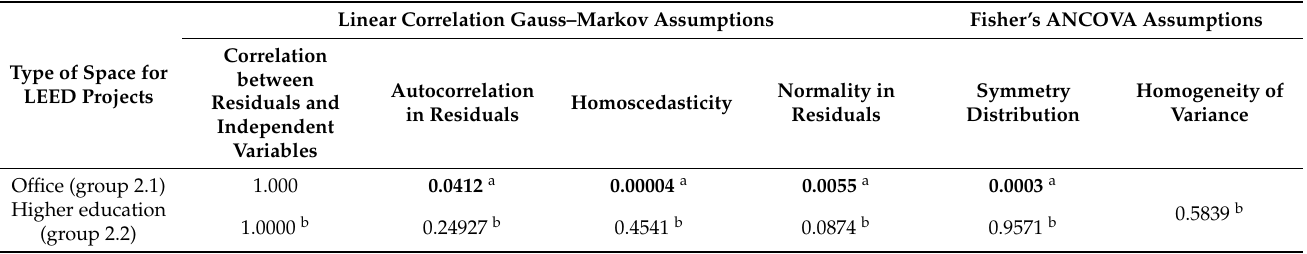
Table A2. Case 2: p -values of Gauss–Markov and Fisher’s ANCOVA assumptions where Y-variable is EAc7 achievement credit and X-covariate is project size from same LEED-NC v4 certified projects.